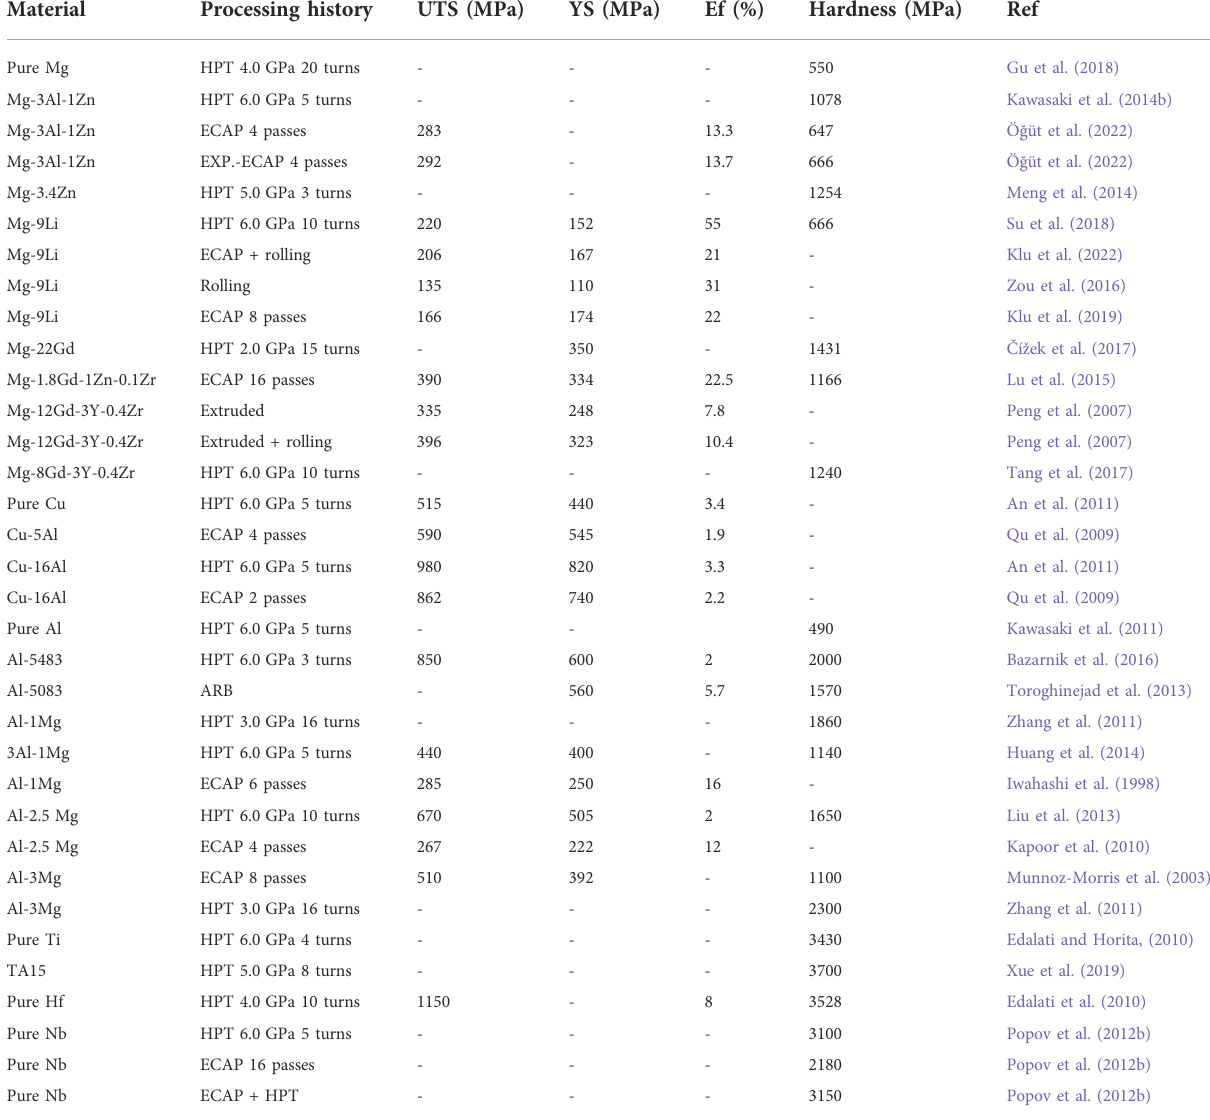
TABLE 3 Mechanical properties of different alloys processed by various SPD techniques.